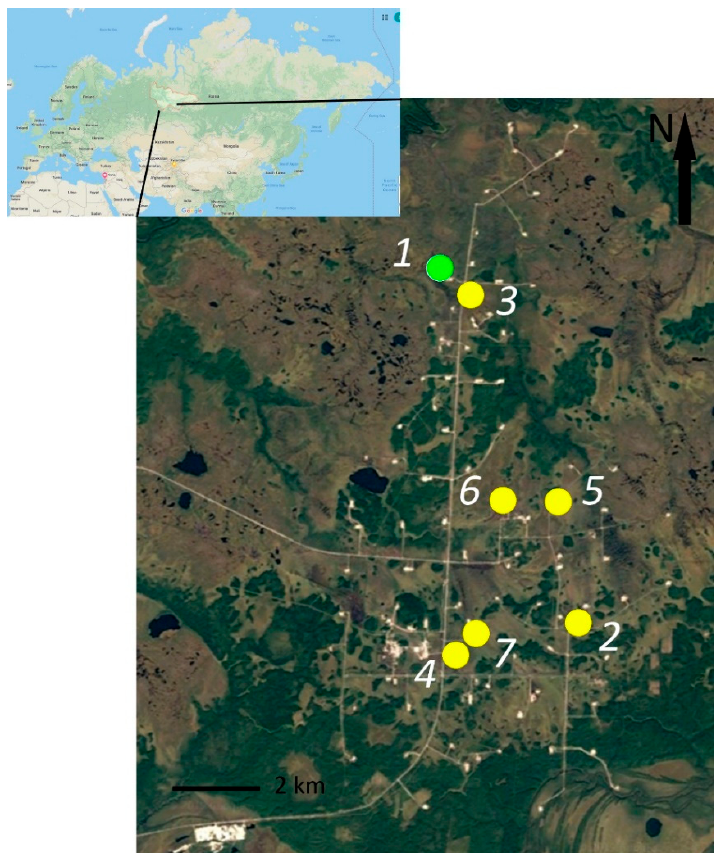
Figure 1. Study sites in the sphagnum bogs of the Ershov oil field in the Vakh River basin: number of studied sites, 1–7; green point, unpolluted site 1; yellow points, polluted sites 2–7.